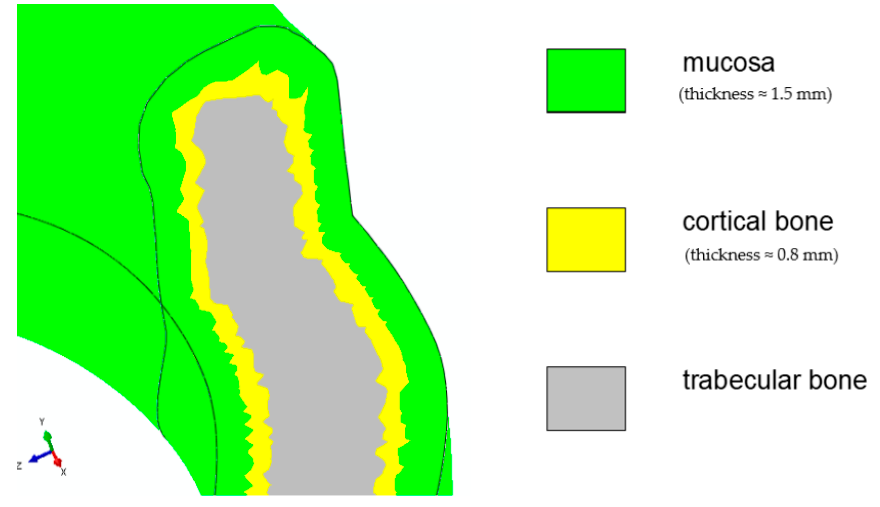
Figure 4. Cross-section of the mandible with assumed geometry of the layers. The implants and bar clip system geometry were reproduced by computer-aided de- sign software (CAD) based on the dimension measurements and product specification data (Osteoplant–Implant System; CEKA Attachments Preci-Line). In Figure 5, the geometry of the implant bar is presented.